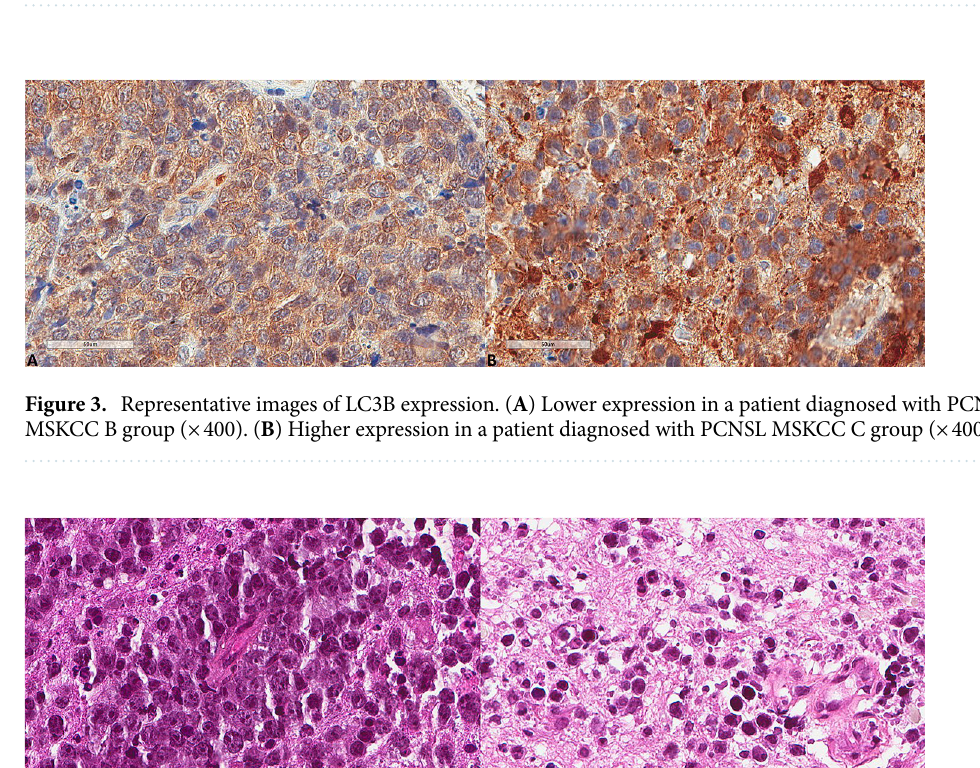
Table 2. Immunohistochemical findings of the autophagic pathway studied.